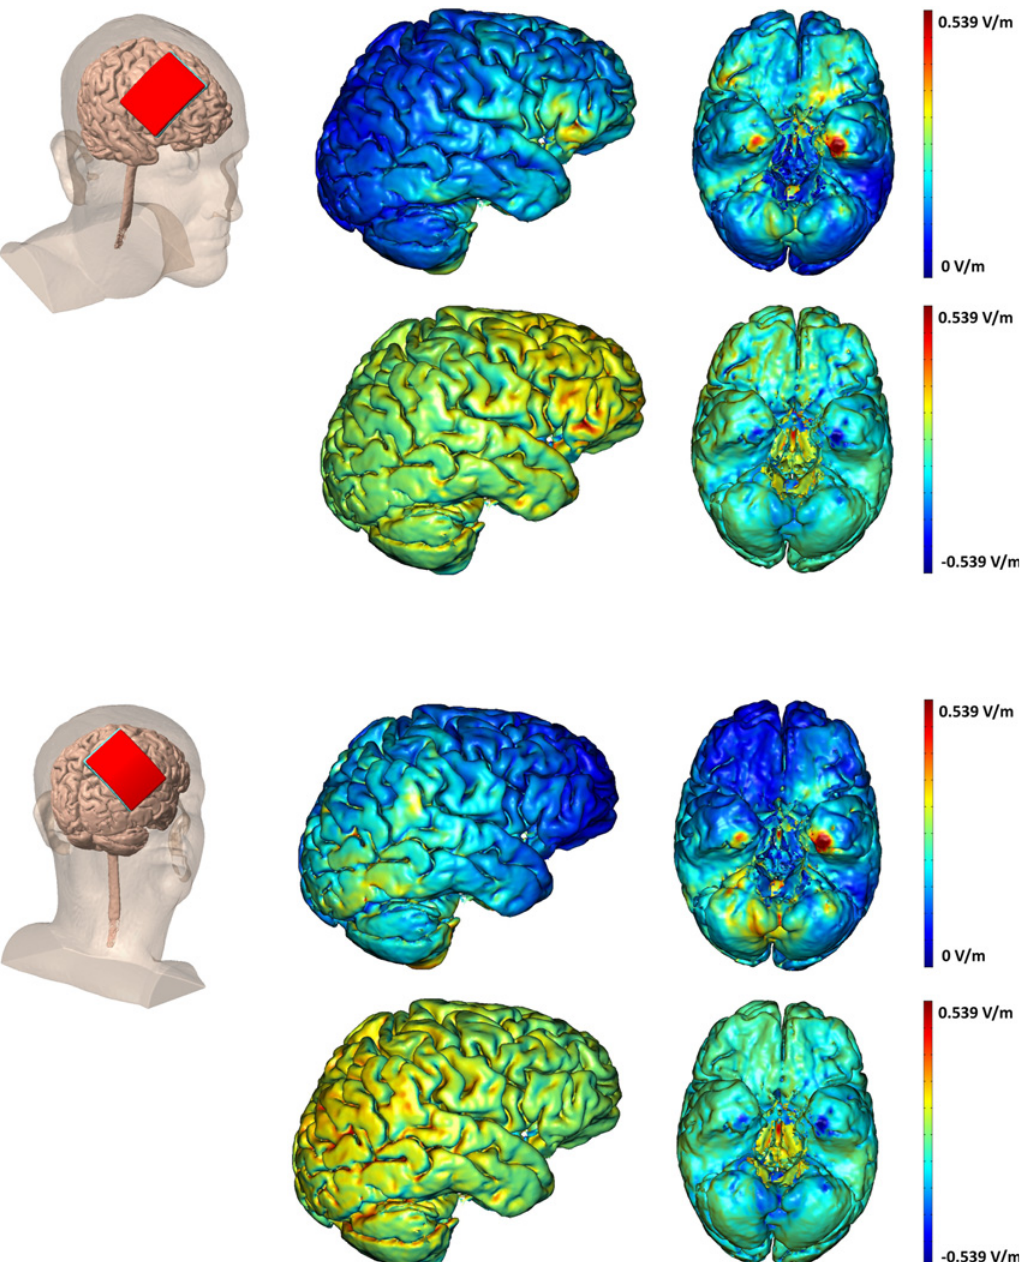
Fig 2. TDCS Current modeling. Modeling of current flow when applying 1.5 mA tDCS for F4 anodal (top) and P4 anodal (bottom) stimulation and the cathodal electrode placed on the contralateral cheek. The top row for each montage shows the electrical field (EF) magnitude plots. The bottom row for each montage is the radial EF plots showing the direction of stimulation. The red shows inward (anodal) EF, while blue represents outward (cathodal) EF.